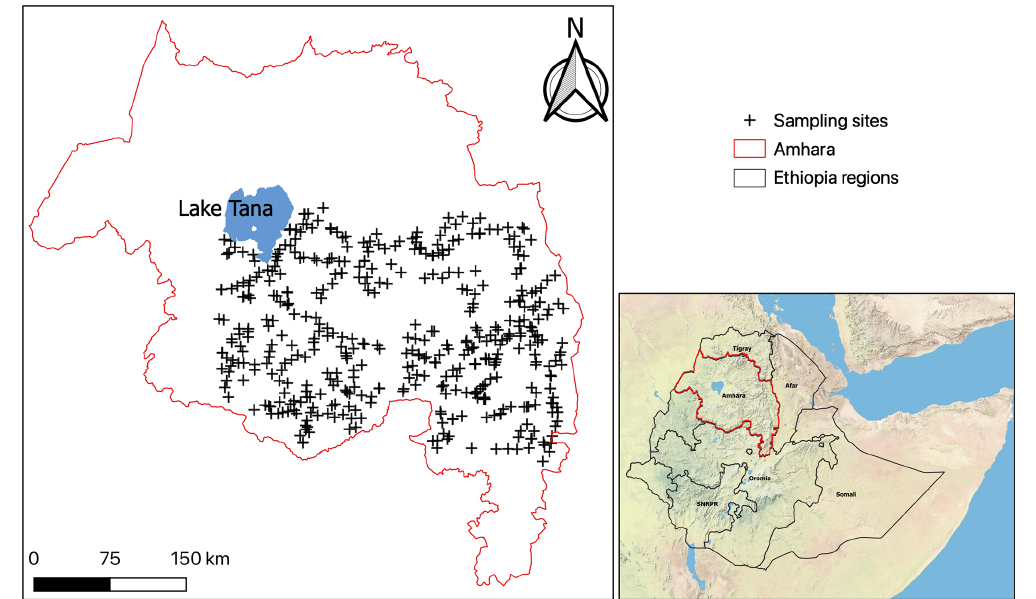
Figure 1. Location of sample sites (black crosses) relative to the border of Amhara Region (red line),